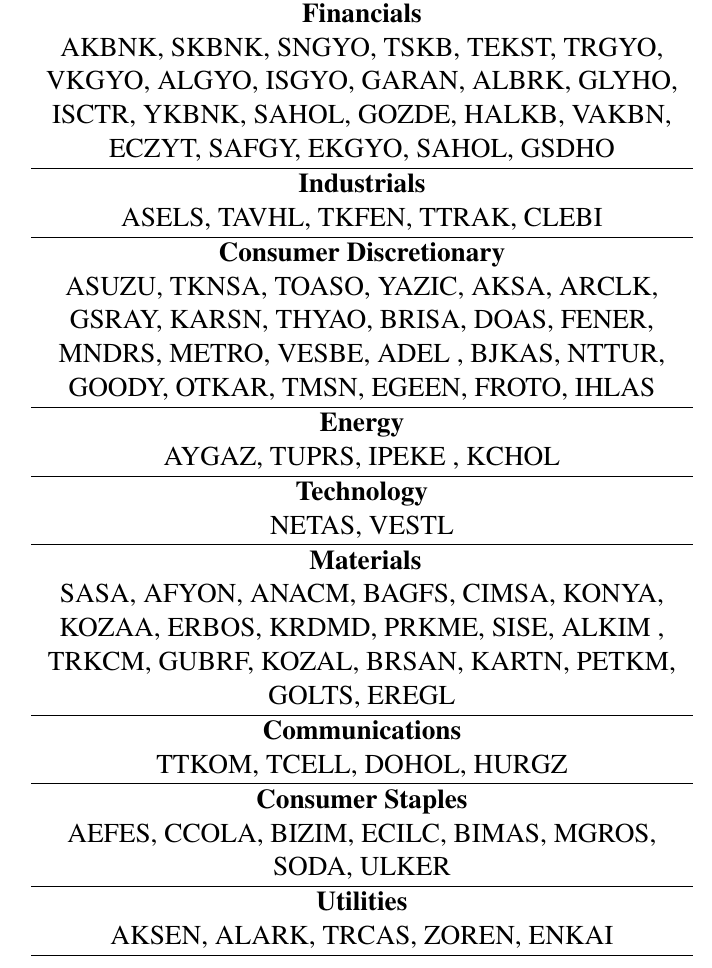
Table 1 Sectors of each considered